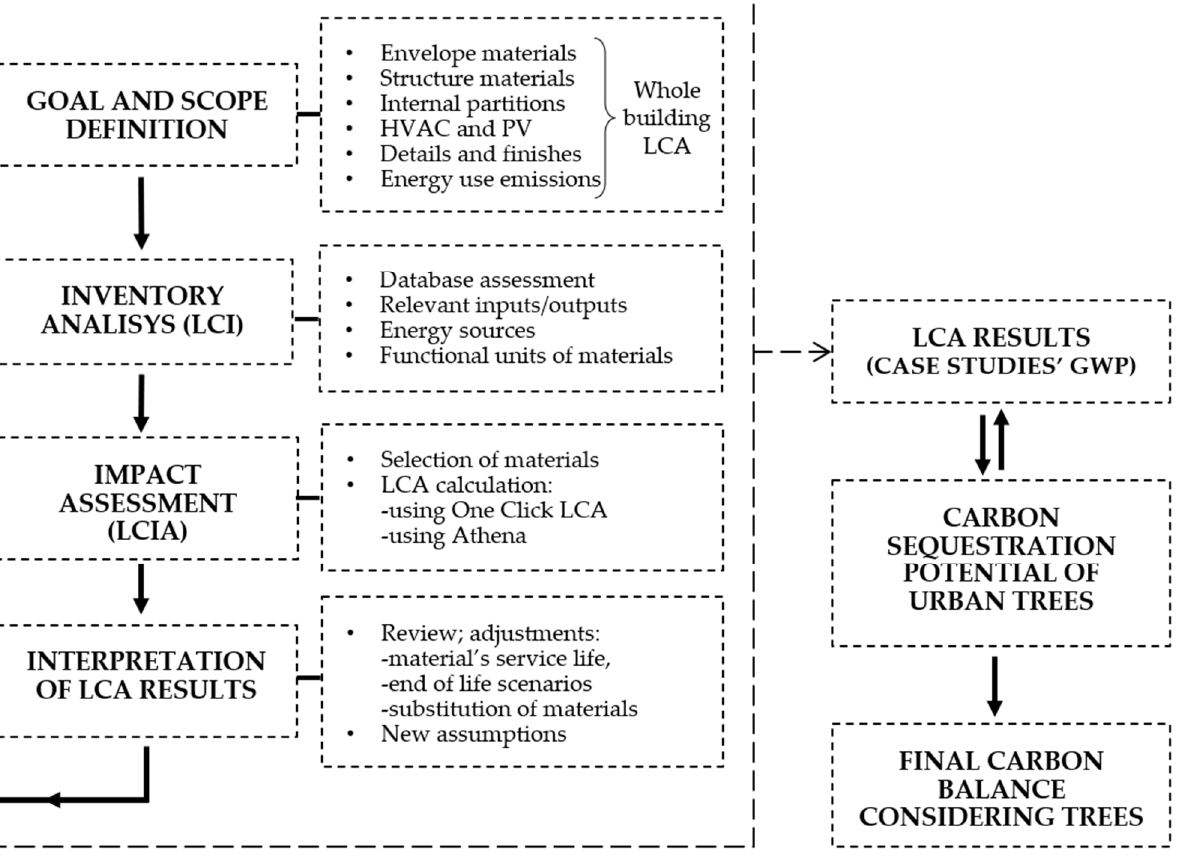
Figure 1. Research framework overview.